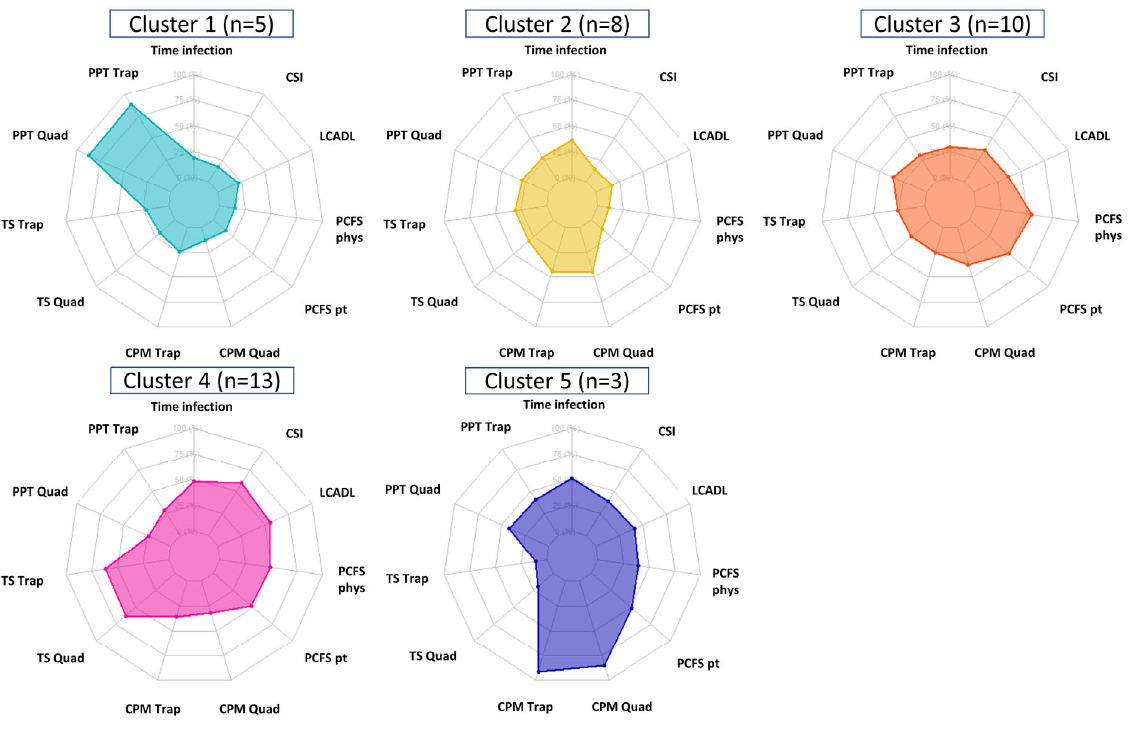
Figure 2. K ‐ means clustering algorithm with five distinct clusters. CPM was coded negatively